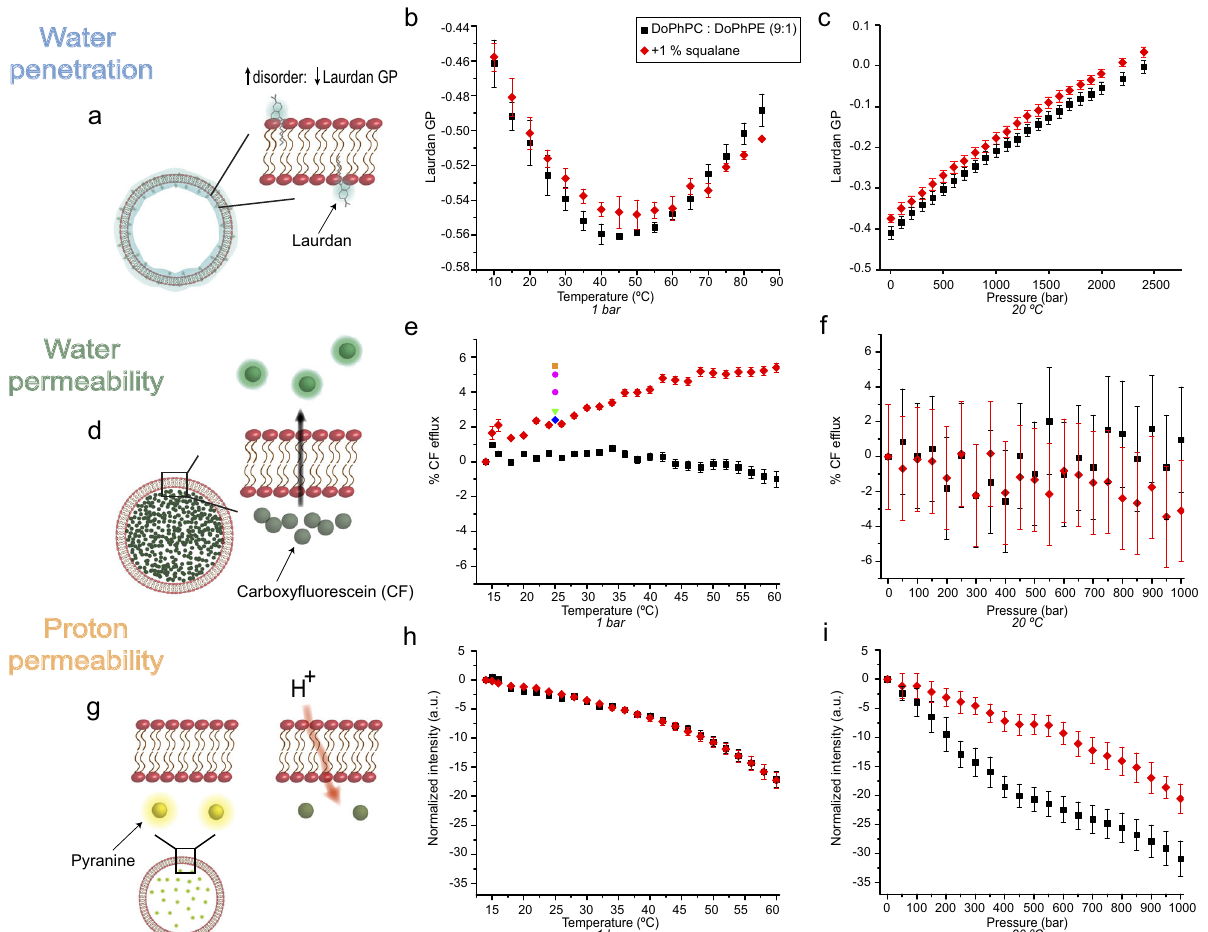
Fig. 5 Squalane modulates membrane physico-chemical properties. Water penetration in the headgroup region of the bilayer measured by laurdan GP ( a – c ), water permeability of lipid bilayers measured by carboxy fl uorescein (CF) ef fl ux ( d – f ), and proton permeability of lipid bilayers measured by pyranine fl uorescence ( g – i ) as a function of temperature (middle column) and pressure (right column) for DoPhPC:DoPhPE (9:1) (black spheres) and in the presence of 1 mol% squalane (red triangles). Dots in the temperature-CF ef fl ux data represent an approximation of the %CF ef fl ux for different lipids at 25 °C: black square: 1,2-dioleoyl- sn -glycero-3-phosphocholine, red spheres: 1-palmitoyl-2-oleoyl-glycero-3-phosphocholine, green triangle: 1,2-dimyristoyl- sn -glycero-3-phosphocholine, and blue diamond: 1,2-diphytanoyl- sn -glycero-3-phosphocholine 62 – 65